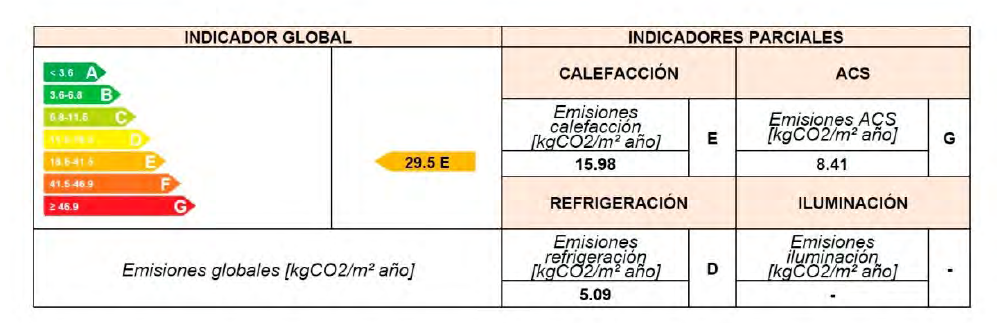
Figure 12. Energy certification label for the current